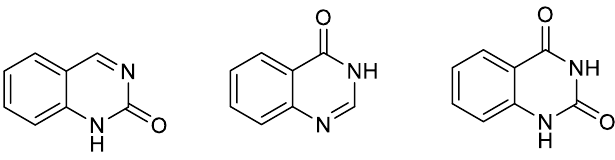
Figure 1. Structure of quinazolinone and quinazolinedione cores [1].